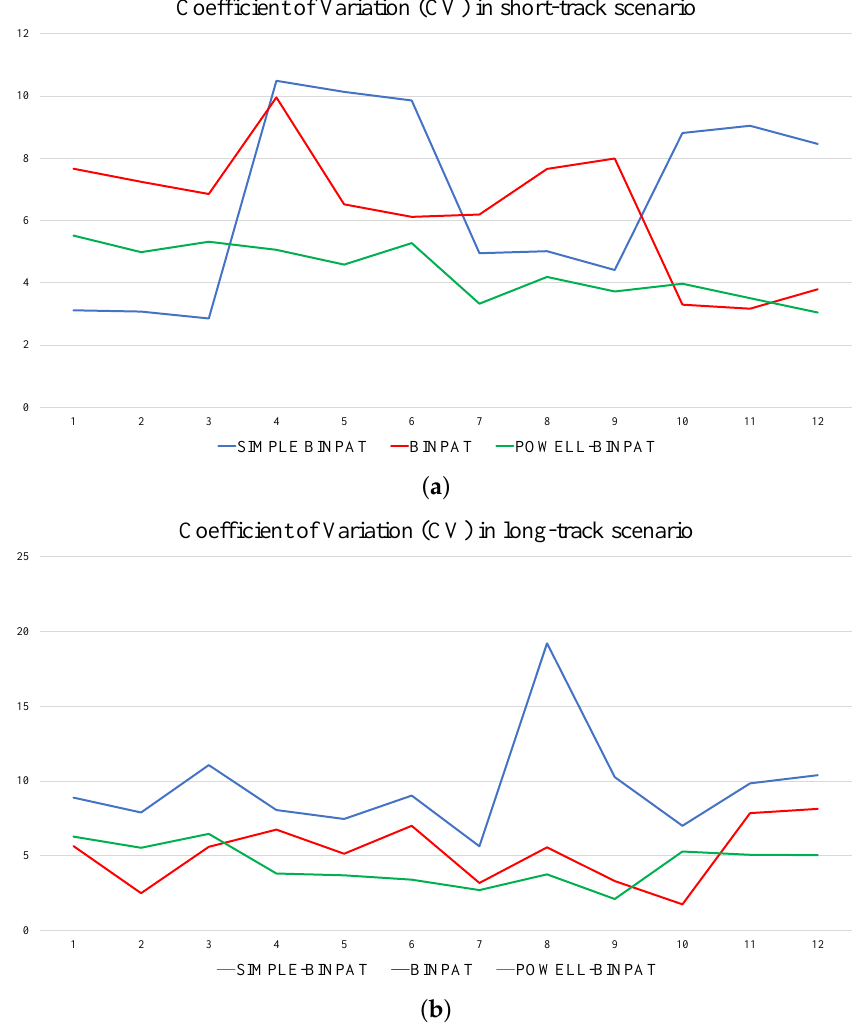
Figure 13. CV behavior obtained from experiments reported in Appendix A: ( a ) short-track scenario results; and ( b ) long-track scenario results. Table 5. Average maximum time for the simulation